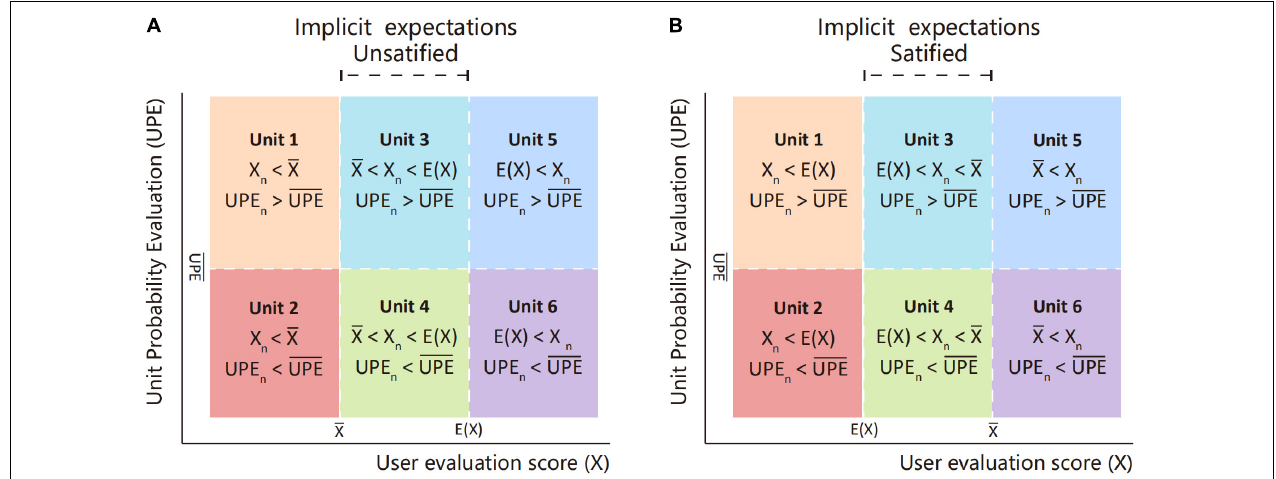
FIGURE 6 | Expectation prediction interval graph of implicit expectations unsatisfied or